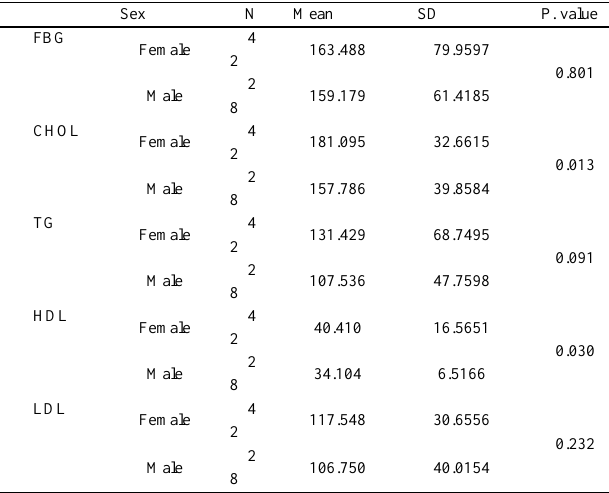
Table 2 : FBG and Lipid profile with T2DM